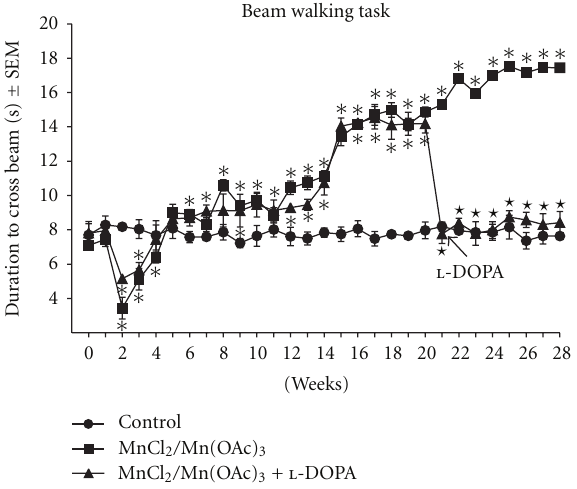
Figure 5: Mean latencies to cross the beam ( ± SEM) before and after Mn-inhalation and after l -DOPA treatment. Note that after 2, 4, 6, and 8 Mn-inhalations the mice significantly decrease the duration to cross the beam, and afterwards showed a significant increase in duration to transverse the beam compared to controls. However, when the mice received the l -DOPA treatment the time wasreduced drastically resembling the values of the control group ( ∗ P < . 001 versus control group; (cid:2) P < . 001 between l -DOPA treatment group versus Mn exposed